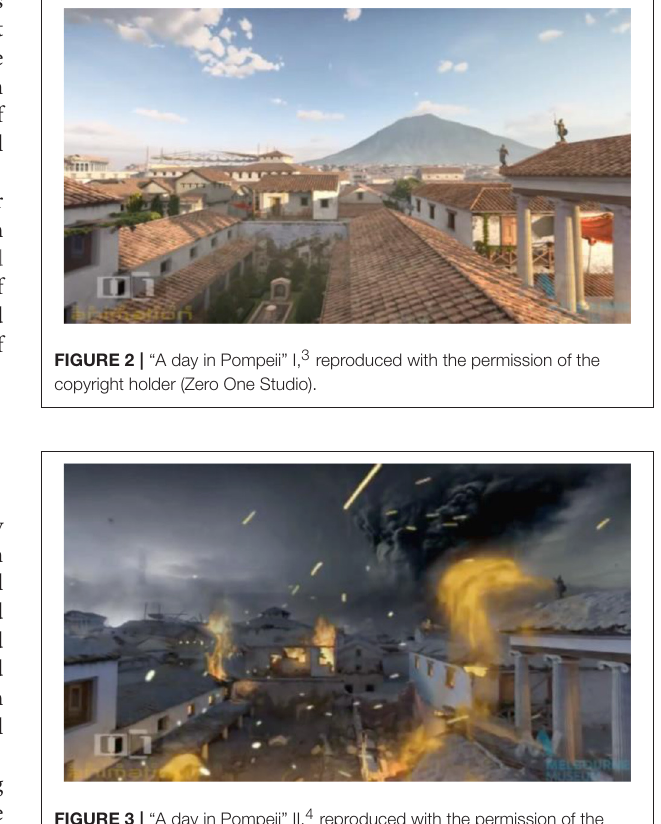
FIGURE 3 | “A day in Pompeii” II, 4 reproduced with the permission of the copyright holder (Zero One Studio).